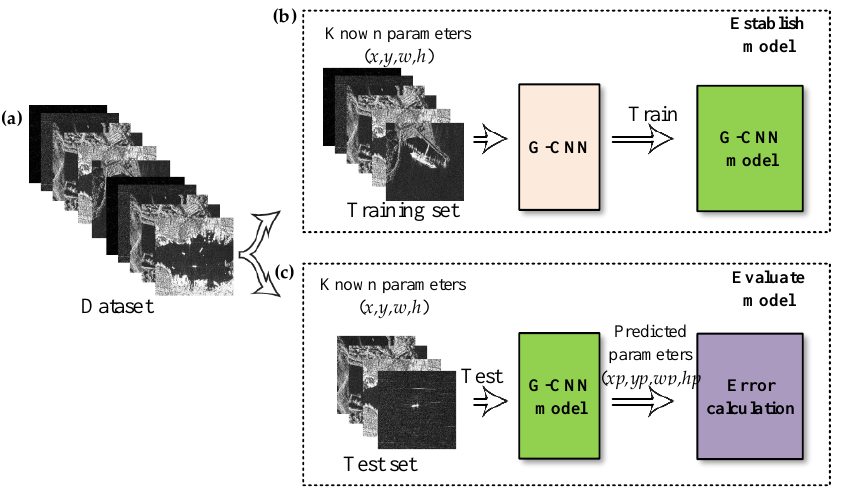
Figure 6. General process of ship detection based on deep learning. (a) Dataset; (b) establish model; (c) evaluate model.